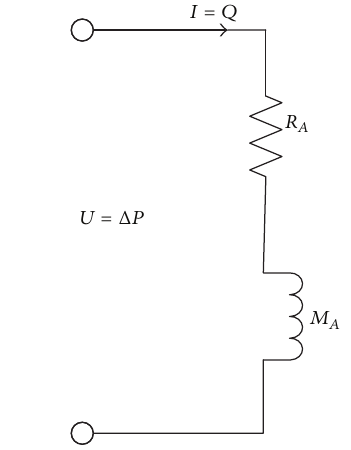
Figure 4: Electrical equivalent circuit of acoustic